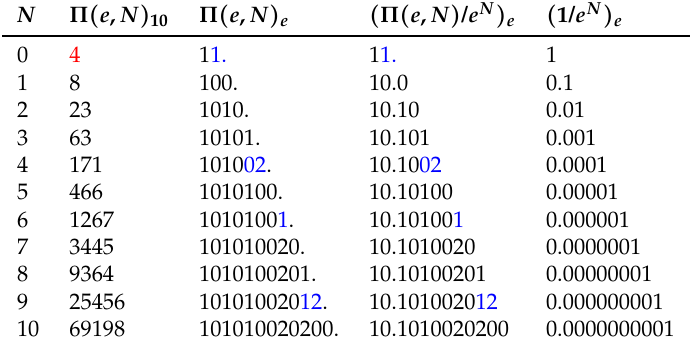
Table 7. Number of collisions Π ( e , N ) given by (13) and approximation of π for b = e . The first column is N . The second column is Π ( e , N ) in the decimal base. The third column is the integer part of the number of collisions Π ( e , N ) written in the base e . The fourth column is the number π with N digits in the fractional part in the base e . The fifth column gives the systematic error according to Equation (55). The case where approximation (14) fails as compared to (13) is highlighted by red. The blue bold digits are incorrectly predicted by the Galperin billiard due to a systematic error. N Π ( e , N ) 10 Π ( e , N ) e